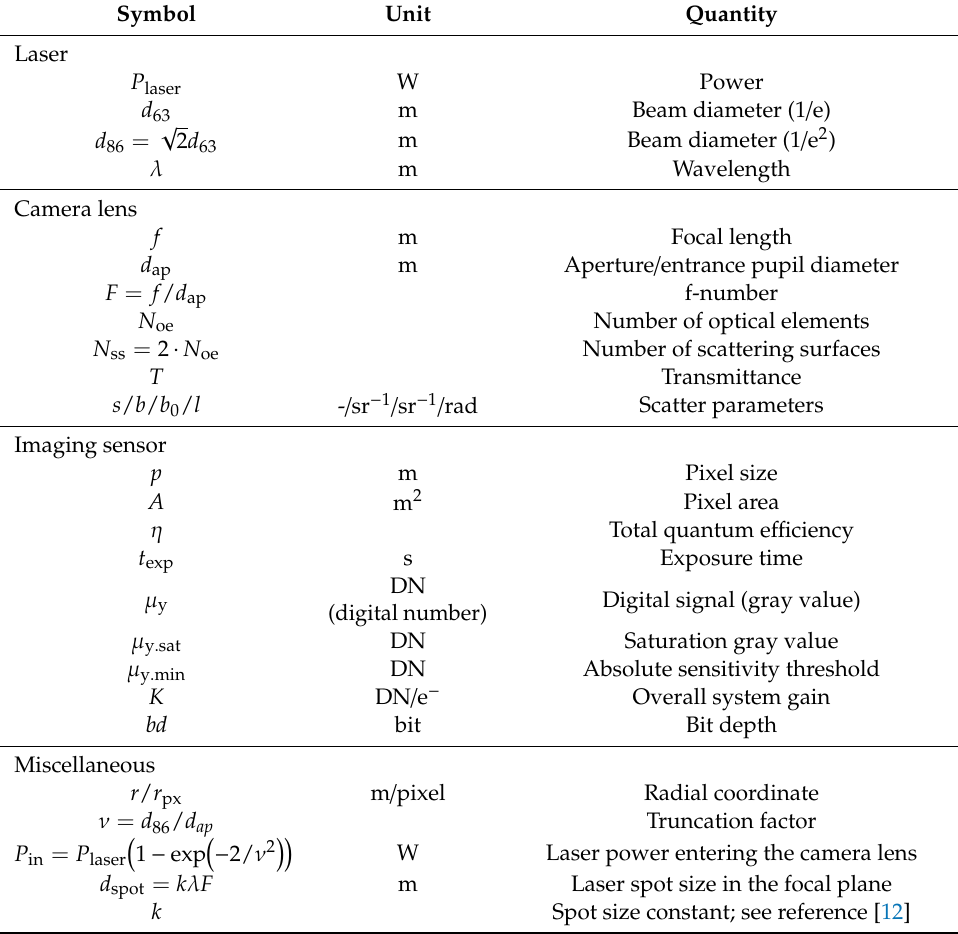
Figure 1. Schematic view of a dazzling scenario. A simple one-element lens represents the usually complex camera lens. Table 1. Parameters used for the theoretical model.